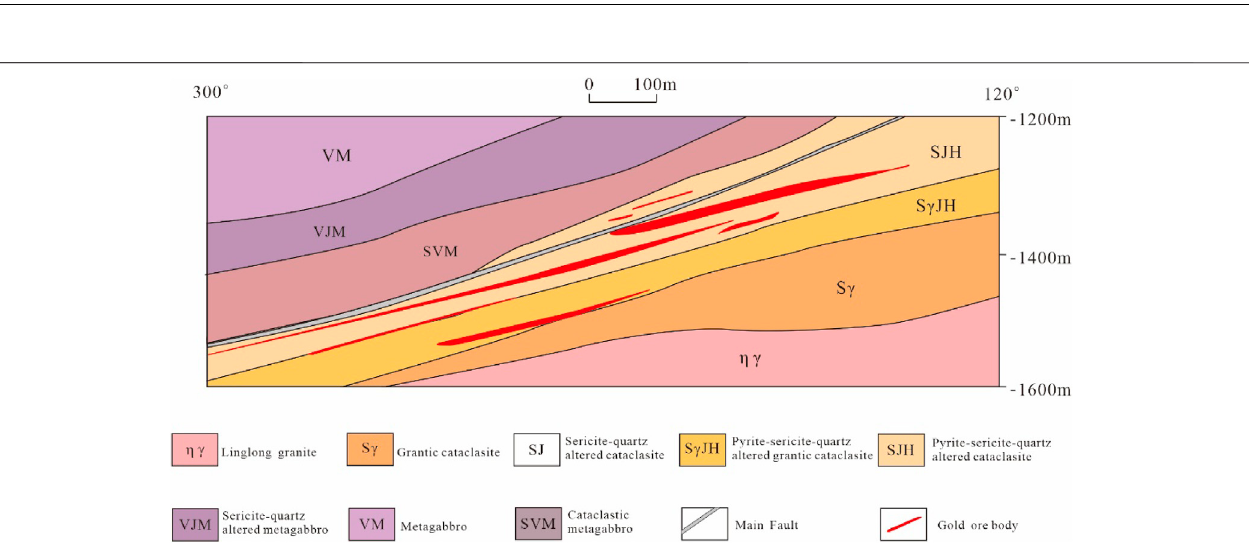
FIGURE 2 | Simpli fi ed geological map of the Zhaoxian gold deposit (modi fi ed from Li et al., 2015).